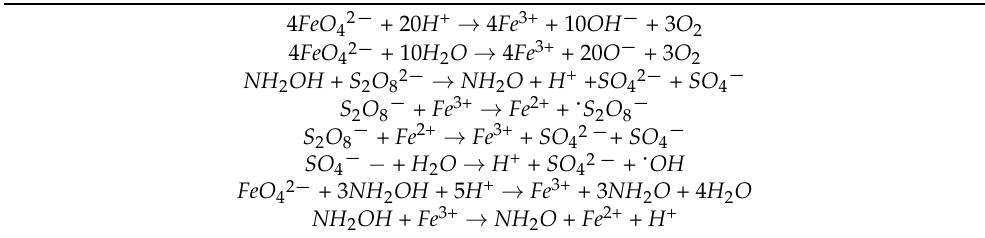
Table 3. Reaction processes involved in the generation of sulpha and hydroxide radicals by the interaction between the Ferrate resultant Fe(III)/Fe(II) species and peroxymonosulphate with the addition of the hydroxylamine